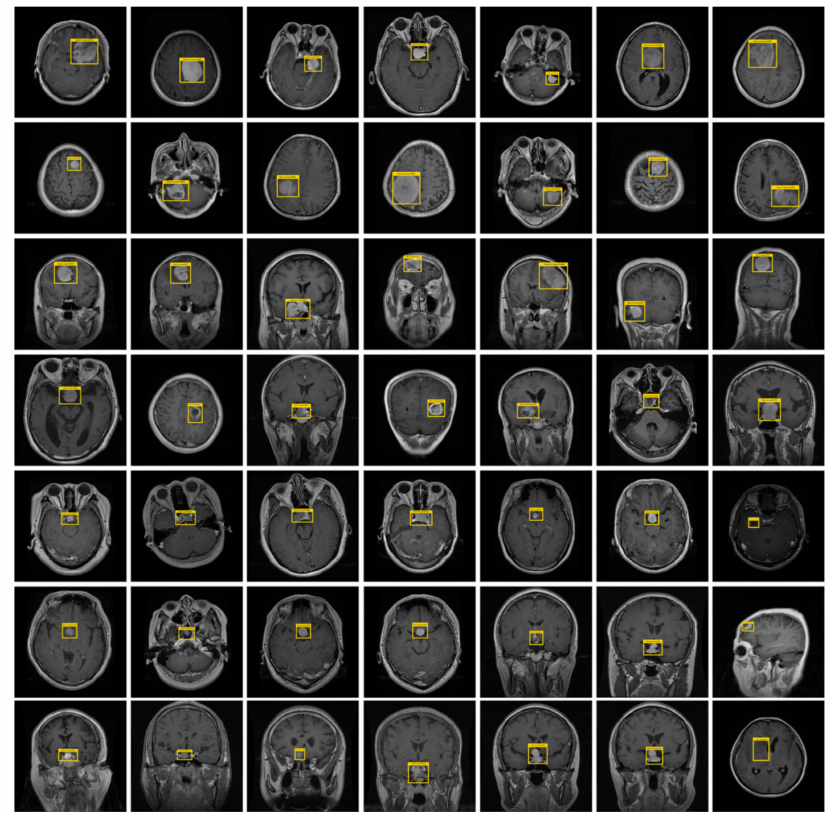
Figure 6. Samples images of localized tumor varying in size, color, location, and shape and under the occurrence of noise, blurring. and contrast